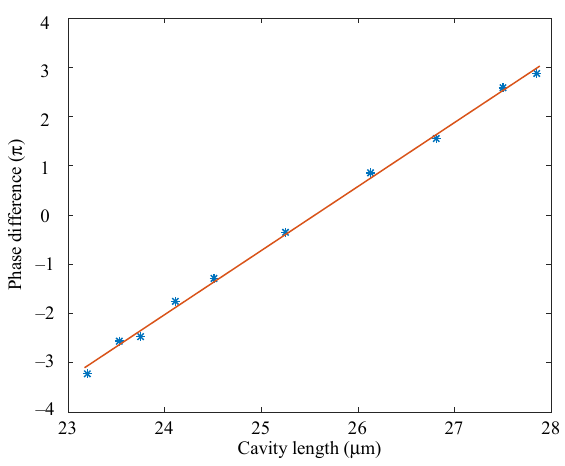
Fig. 12 Fitting curve of cavity length and phase difference.